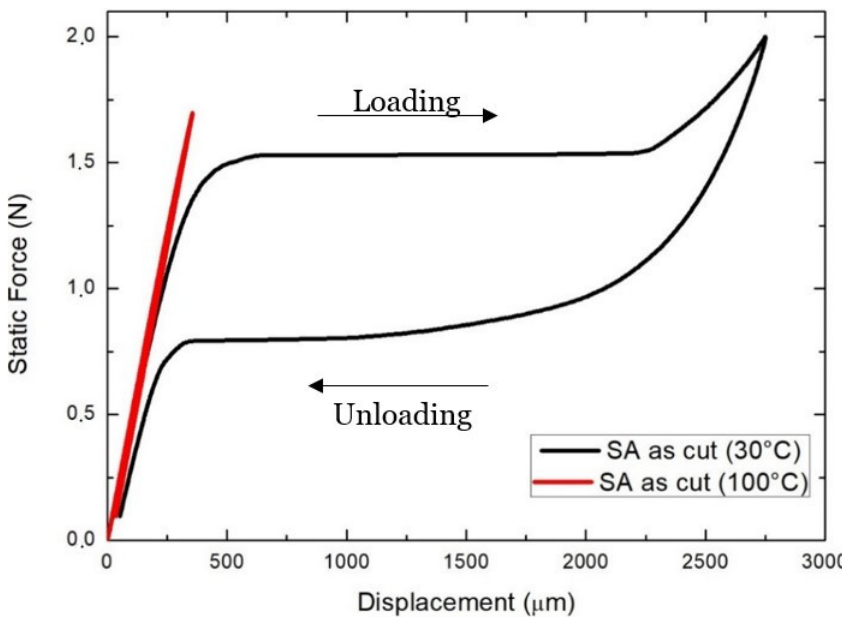
Figure 9. Static force/displacement curve of SA diamond-like element at low (30 °C) and high (100 °C) temperatures.